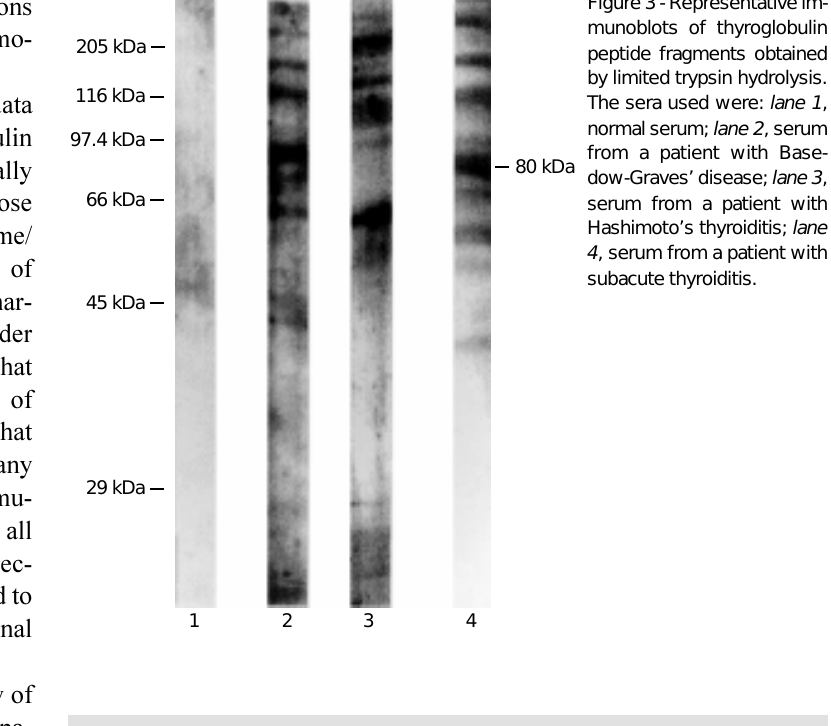
Table 1 - Absolute and relative frequencies of reactivity of anti-thyroglobulin antibody with tryptic fragments of human thyroglobulin in patients with autoimmune thyroid disease and subacute